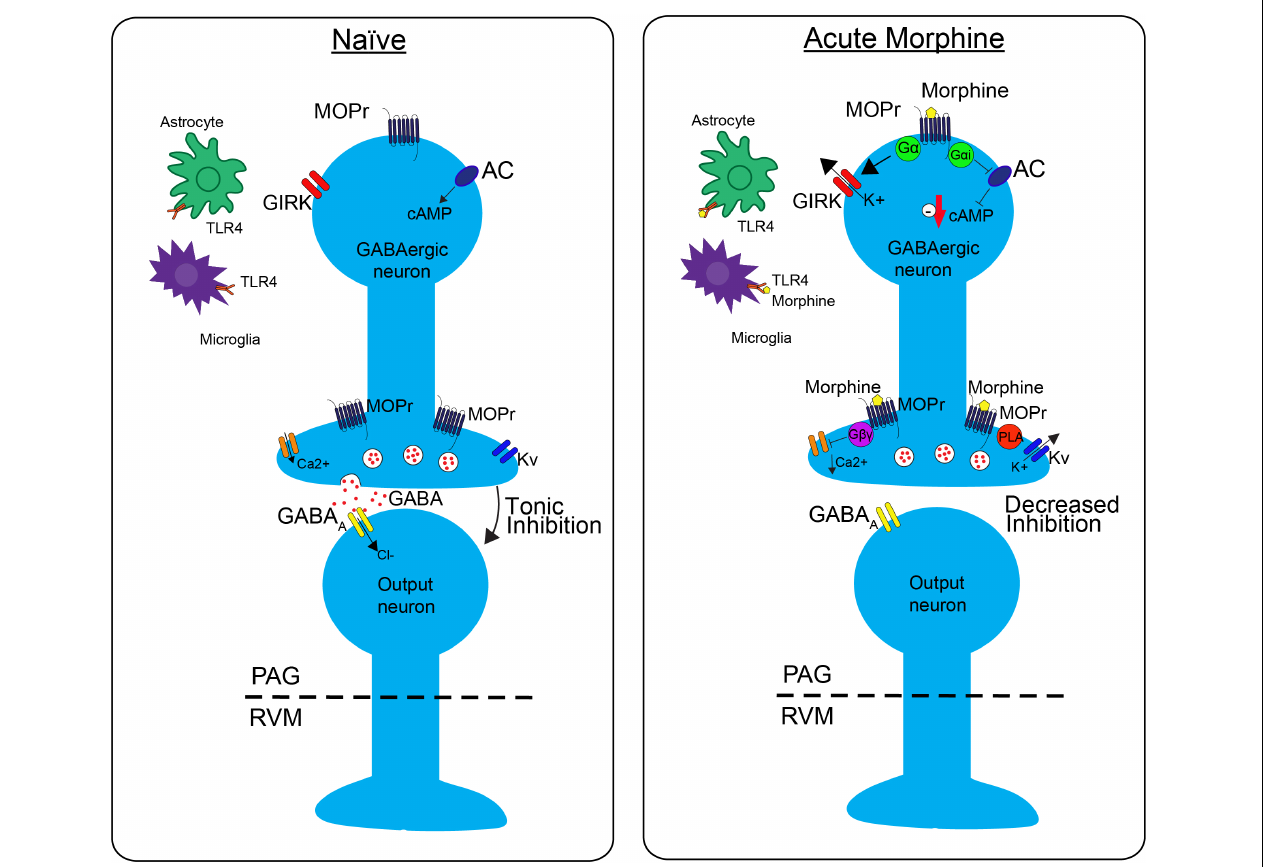
FIGURE 1 | The effects of morphine on neuronal transmission in the descending pain pathway. In the naïve state , GABAergic interneurons in the periaqueductal gray (PAG) fire tonically, thereby producing a steady release of GABA and inhibition of PAG output neurons. Upon administration of acute morphine , postsynaptic mu opioid receptor (MOPr) activate GIRK channels via G α proteins resulting in K+ release and hyperpolarization of the neuron. Additionally, MOPr activate G i / o proteins, which result in the inhibition of adenylyl cyclase (AC) and decrease cAMP production. Morphine binding of presynaptic MOPr inhibits voltage dependent calcium (Ca 2 + ) conductances via G βγ proteins and activated voltage dependent potassium conductances (Kv) via Phospholipase A (PLA). Overall, these two mechanisms block release of the neurotransmitter GABA, therefore suppressing inhibition, increasing output, of the PAG neurons projecting to the rostral ventromedial medulla (RVM). Acute morphine treatment also activates toll-like receptor 4 (TLR4) receptors on astrocytes and microglia in the PAG inducing several signaling